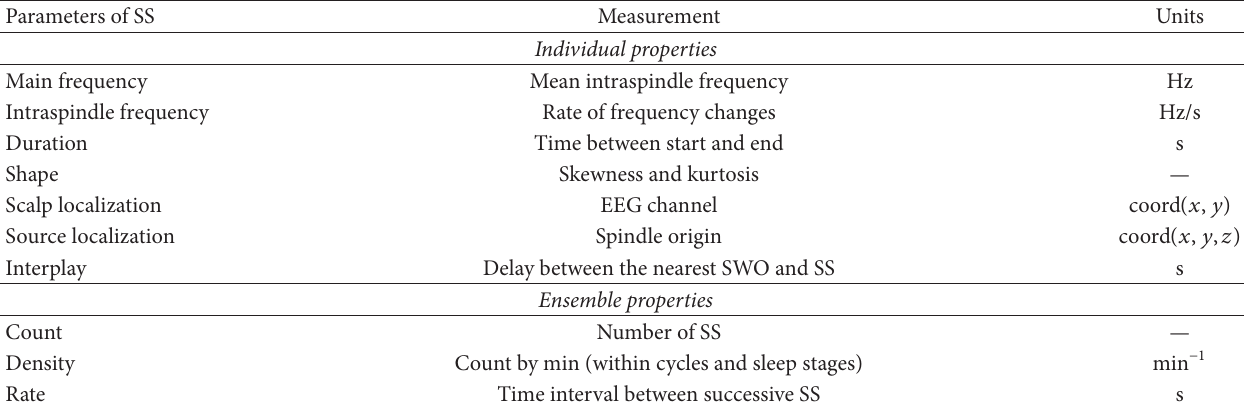
Table 1: Main characteristics of sleep spindle (SS). SWO: Slow Wave Oscillations; coord: